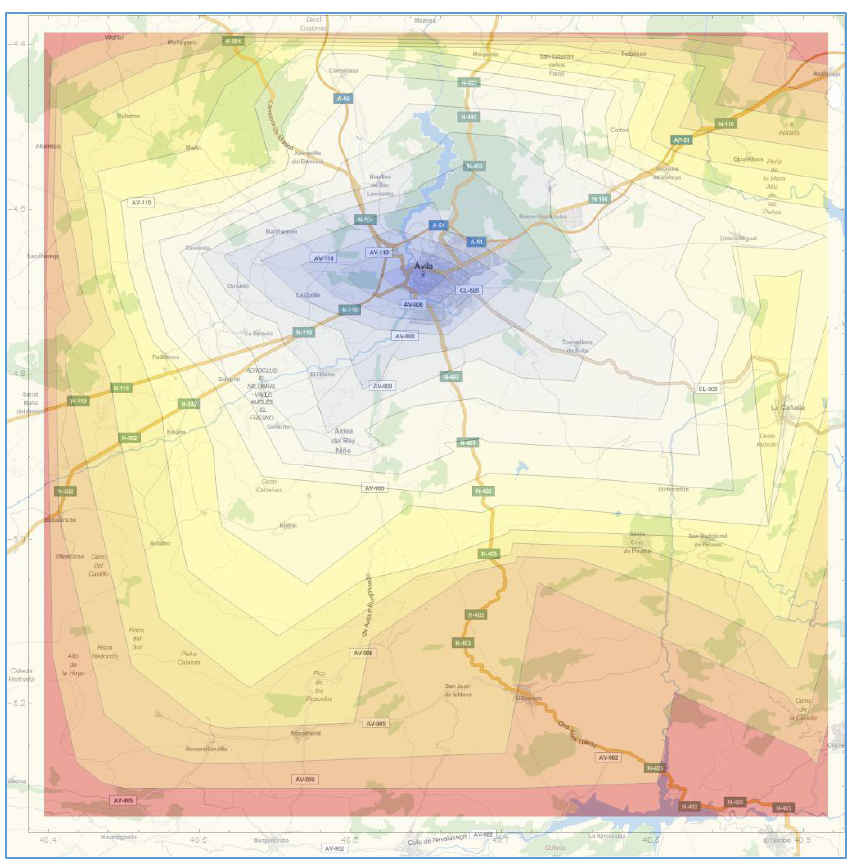
Figure 2. Realistic time